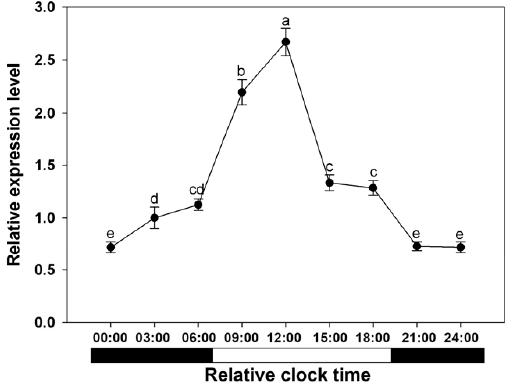
Figure 7. BcAMT1;5 expression in response to circadian rhythm and light intensity in flowering Chinese cabbage roots. Seedlings were grown in normal nutrient solution, 150 μ mol m − 2 s − 1 light intensity and a 12 h/12 h light/dark period (light from 7:00 to 18:59; darkness from 19:00 to 6:59). Roots were collected at 3 h intervals. Black boxes represent the dark period, the white boxes represent the light period. Values and error bars indicate means ± SE ( n = 3). Different lowercase letters show significant differences at p < 0.05.